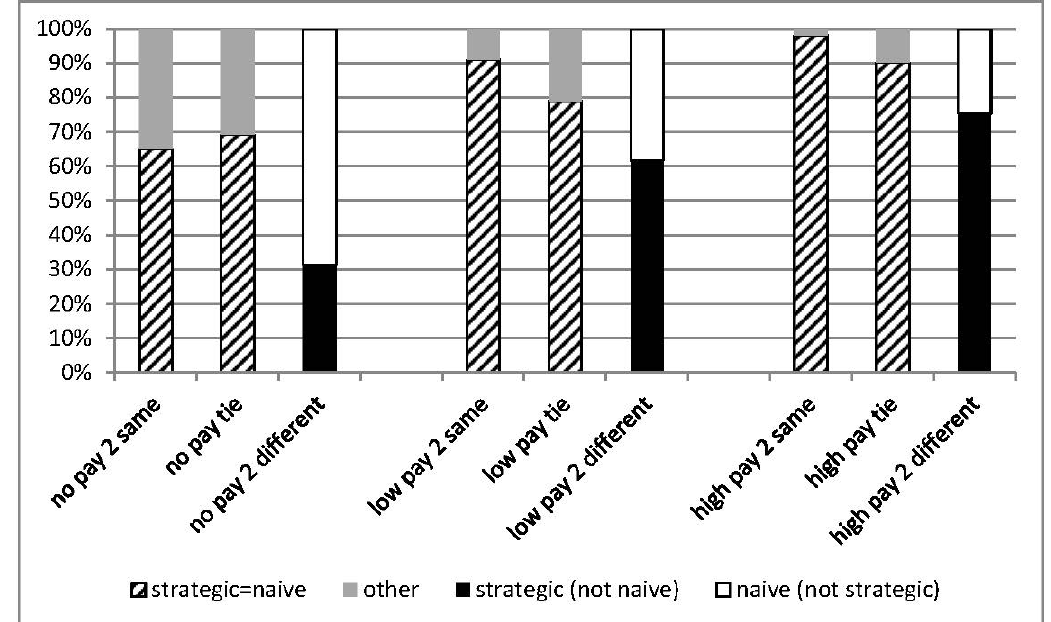
Figure 3. Individual behavior under Partial Information